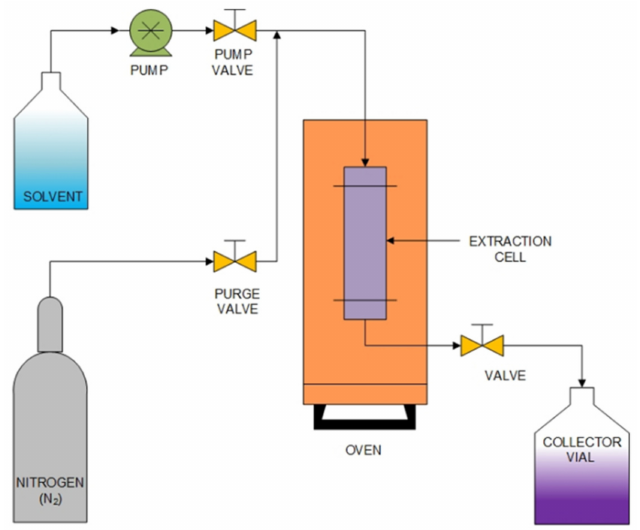
Figure 6. Schematic diagram of pressurized liquid extraction apparatus.